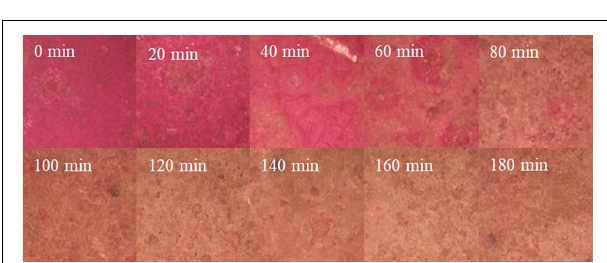
FIGURE 9 | Rhodamine B spots on the surface of EBFS-1180 ceramic at different irradiation time.